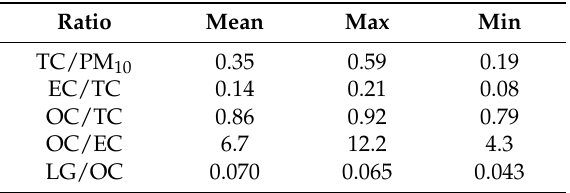
Table 3. The annual mean of total carbon to ambient aerosol (TC/PM 10 ), elemental carbon to total carbon (EC/TC), organic carbon to total carbon (OC/TC), organic carbon to elemental carbon (OC/EC), and levoglucosan to organic carbon (LG/OC) ratios for 102 samples.